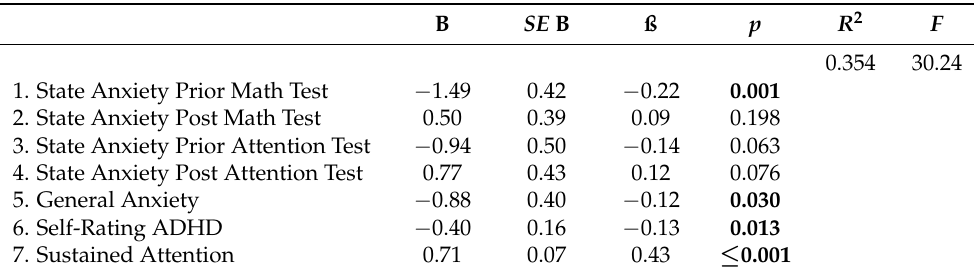
Table 2. Linear regression model of math achievement.